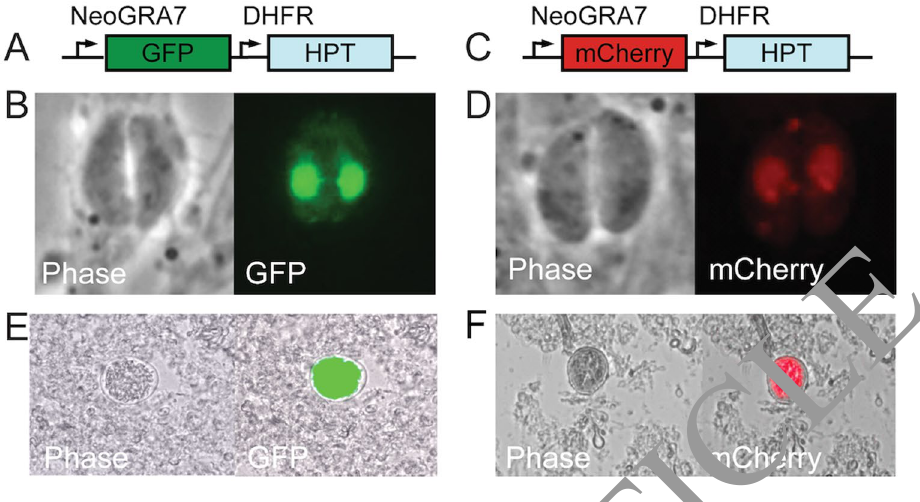
Figure 2. Stable expression of GPF and mCherry in tachyzoites and tissue cysts of N. caninum . ( A ) Diagram of the expression cassette encoding GFP, driven by the N. caninum GRA7 promoter, ( B ) GFP-expressing N. caninum tachyzoites, microscope magnification: 63x, ( C ) diagram of the expression cassette encoding mCherry, driven by the N. caninum GRA7 promoter, ( D ) mCherry-expressing N. caninum tachyzoites, microscope magnification: 63x, ( E ) tissue cyst found in the brain of mice infected for 30 days with GFP-expressing N. caninum , microscope magnification: 40x, ( F ) tissue cyst found in the brain of mice infected for 30 days with mCherry-expressing N. caninum , microscope magnification: